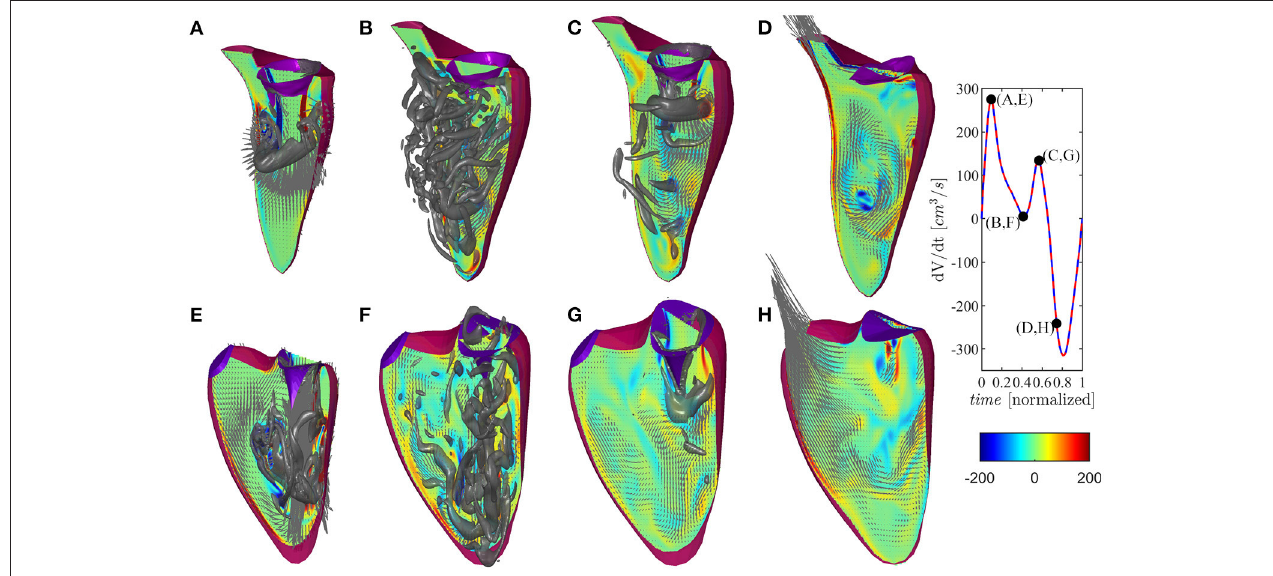
FIGURE 4 | Flow pattern inside the left and right ventricles at four instants: (A,E) early filling wave, (B,F) diastasis, (C,G) atrial contraction wave, (D,H) beginning of systole, as indicated in the volume–rate curves in the insets [red color for left ventricle (LV) and blue color for right ventricle (RV)]. The normal vorticity is shown by red to blue color from -200 units to 200 units equal to the inverse of the heartbeat period and the velocity vector (ever 4 grid points) on a longitudinal plane; the three-dimensional gray surfaces represents the iso-surface of λ 2